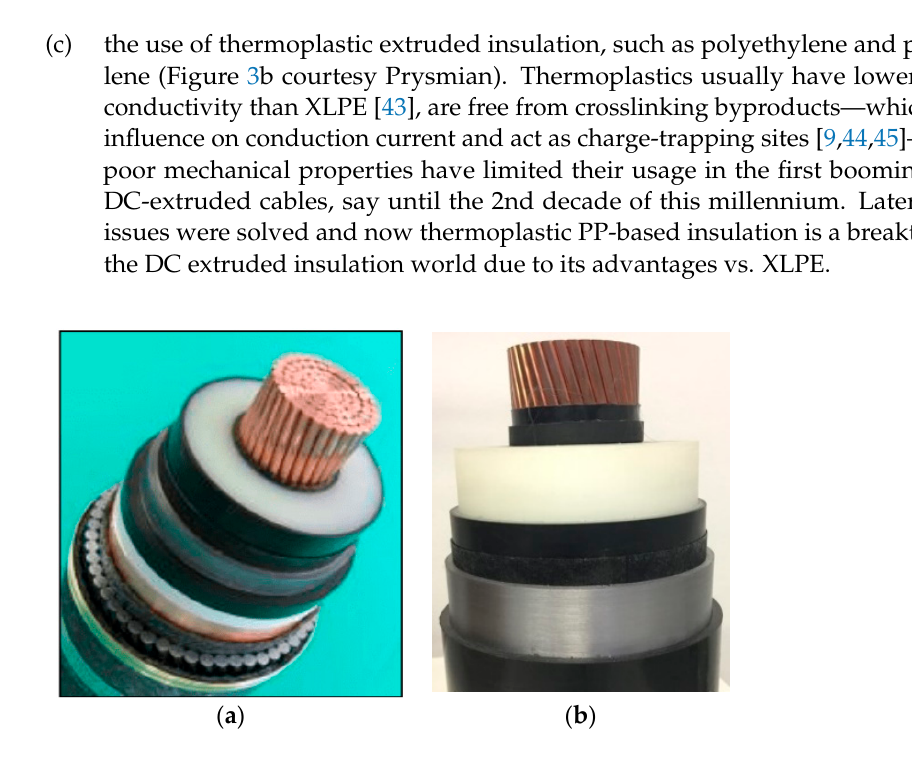
Figure 3. ( a ) XLPE-insulated HVDC subsea cable (courtesy Sumitomo Electric, © 2019 IEEE. Reprinted, with permission, from Mazzanti, G. Activities of the deis technical committee on HVDC cable systems (cables, joints, and terminations). IEEE Electr. Insul. Mag. 2019 , 35 , 59–61); ( b ) HPTE-insulated HVDC land cable (courtesy